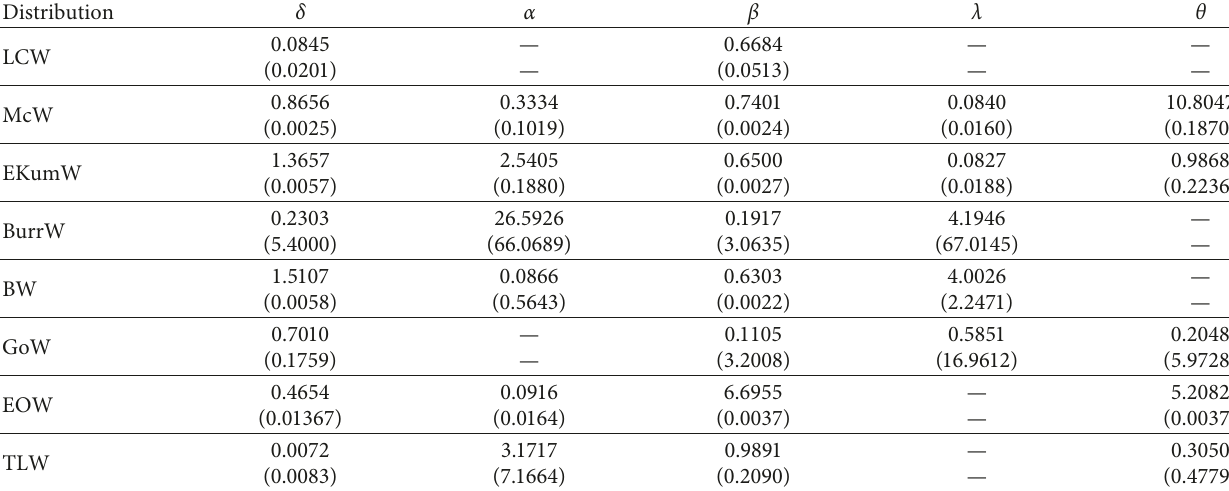
Table 7: MLEs and their standard errors (in parentheses) for survival time